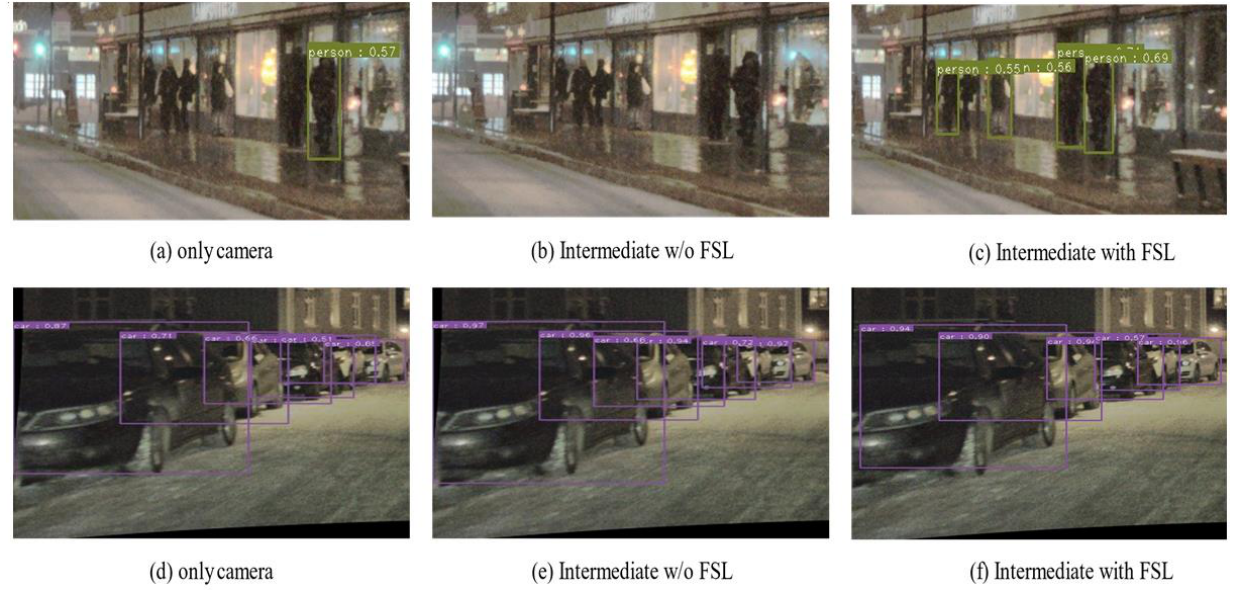
Figure 7. Snow, fog/nighttime detection result. ( a – c ): Snow/nighttime, only camera, intermediate w/o FSL, intermediate with FSL (proposed). ( d – f ): Fog/nighttime, only camera, intermediate w/o FSL, intermediate with FSL